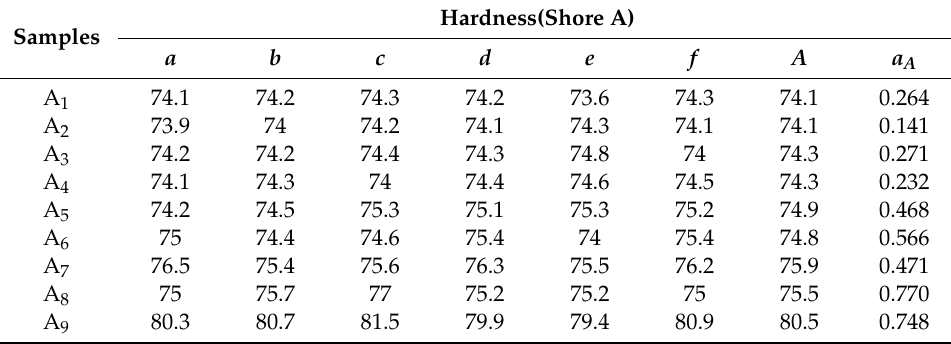
Table 3. Hardness test results of samples from Factory